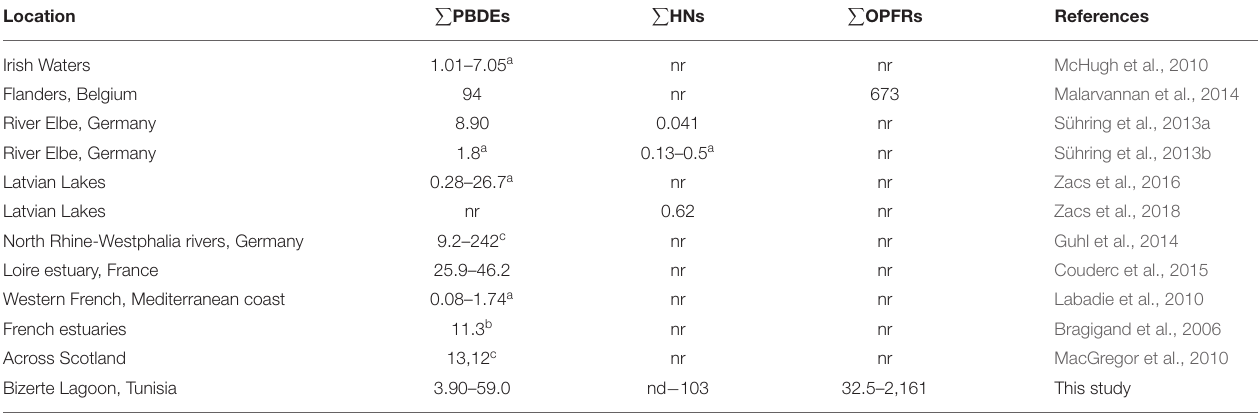
TABLE 2 | PBDE, HN, and OPFR range of concentrations or mean values (expressed in ng/g lw) found in European eel samples collected around the world. Location P PBDEs P HNs P